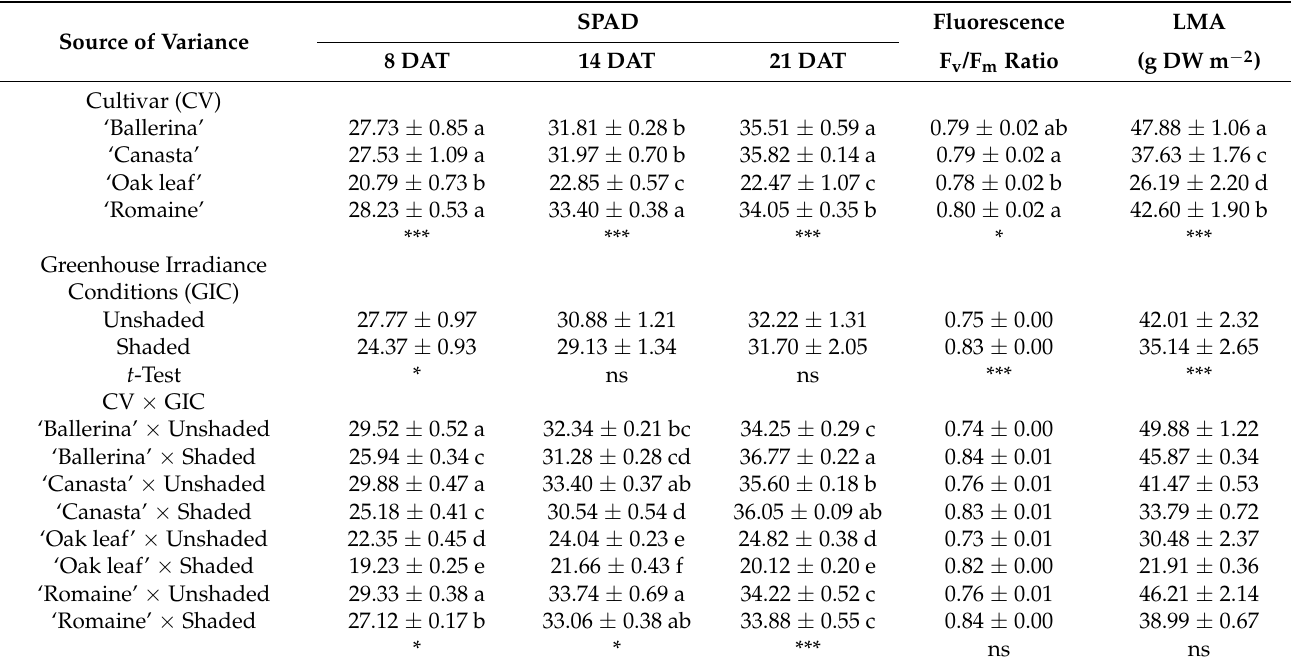
Table 3. Effect of cultivar and greenhouse irradiance conditions on SPAD index, fluorescence (F v /F m ratio) and leaf mass area (LMA) in Lactuca sativa L.